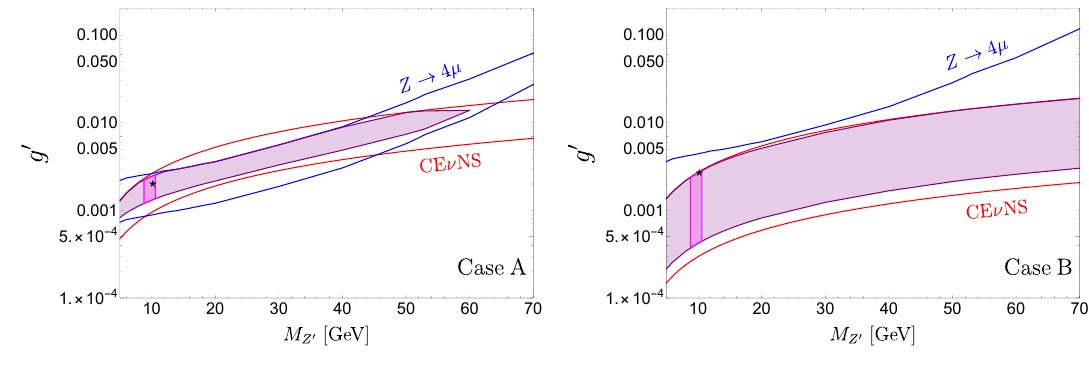
Figure 4. 2 (cid:27) allowed regions for Case A (left) and 1 (cid:27) allowed regions for Case B (right) from COHERENT with a large LAr detector (within the red curves) and HL-LHC Z ! 4 (cid:22) decays (within the blue curves). The purple shaded regions (2 (cid:27) for case A and 1 (cid:27) for Case B) are from our joint analysis. The magenta shaded regions are the allowed regions after including the LHCb bound as a prior. The stars mark the best (cid:12)t points from our joint analysis.